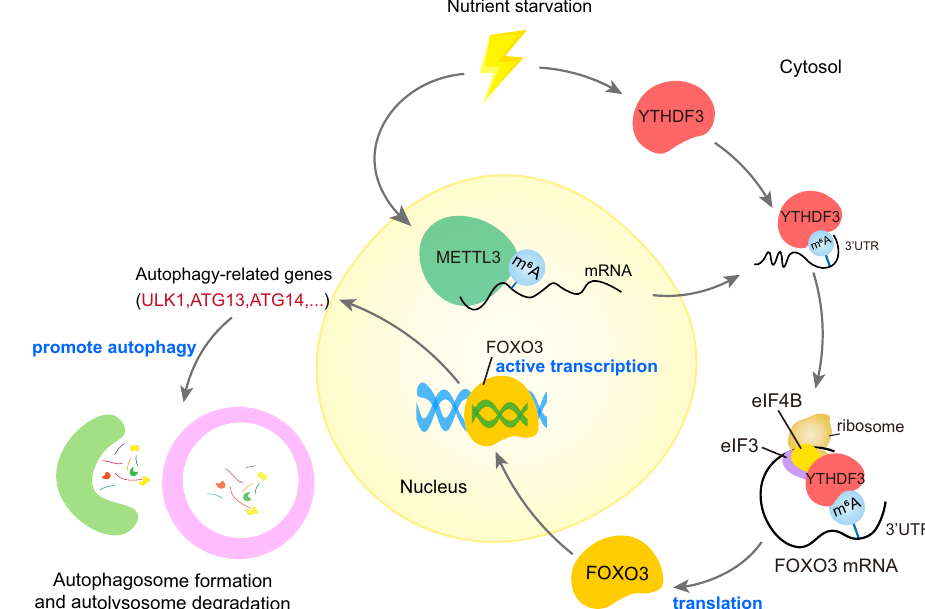
Fig. 9 | A proposed model of YTHDF3-promoted autophagy induction. Under nutrient deprivation, the m 6 A reader YTHDF3 and m 6 A writer METTL3 are up- regulated. The latter promotes m 6 A hypermethylation at the CDS and 3 ’ UTR regionsaroundthestopcodonoftheFOXO3transcript.YTHDF3facilitatesFOXO3